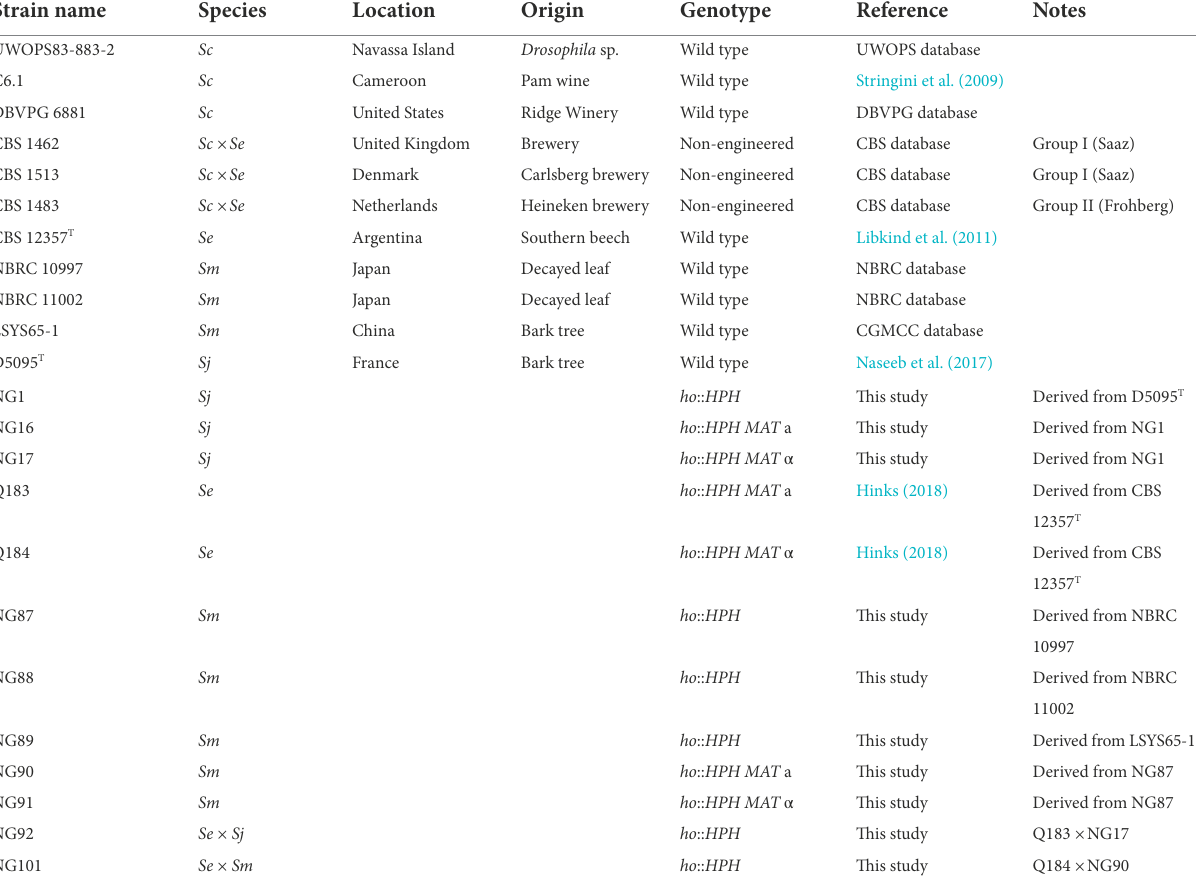
TABLE 1 List of relevant Saccharomyces strains [ S. pastorianus ( Sc × Se ), S. cerevisiae ( Sc ), S. eubayanus ( Se ), S. mikatae ( Sm ), S. jurei ( Sj )] used in this study. Strain